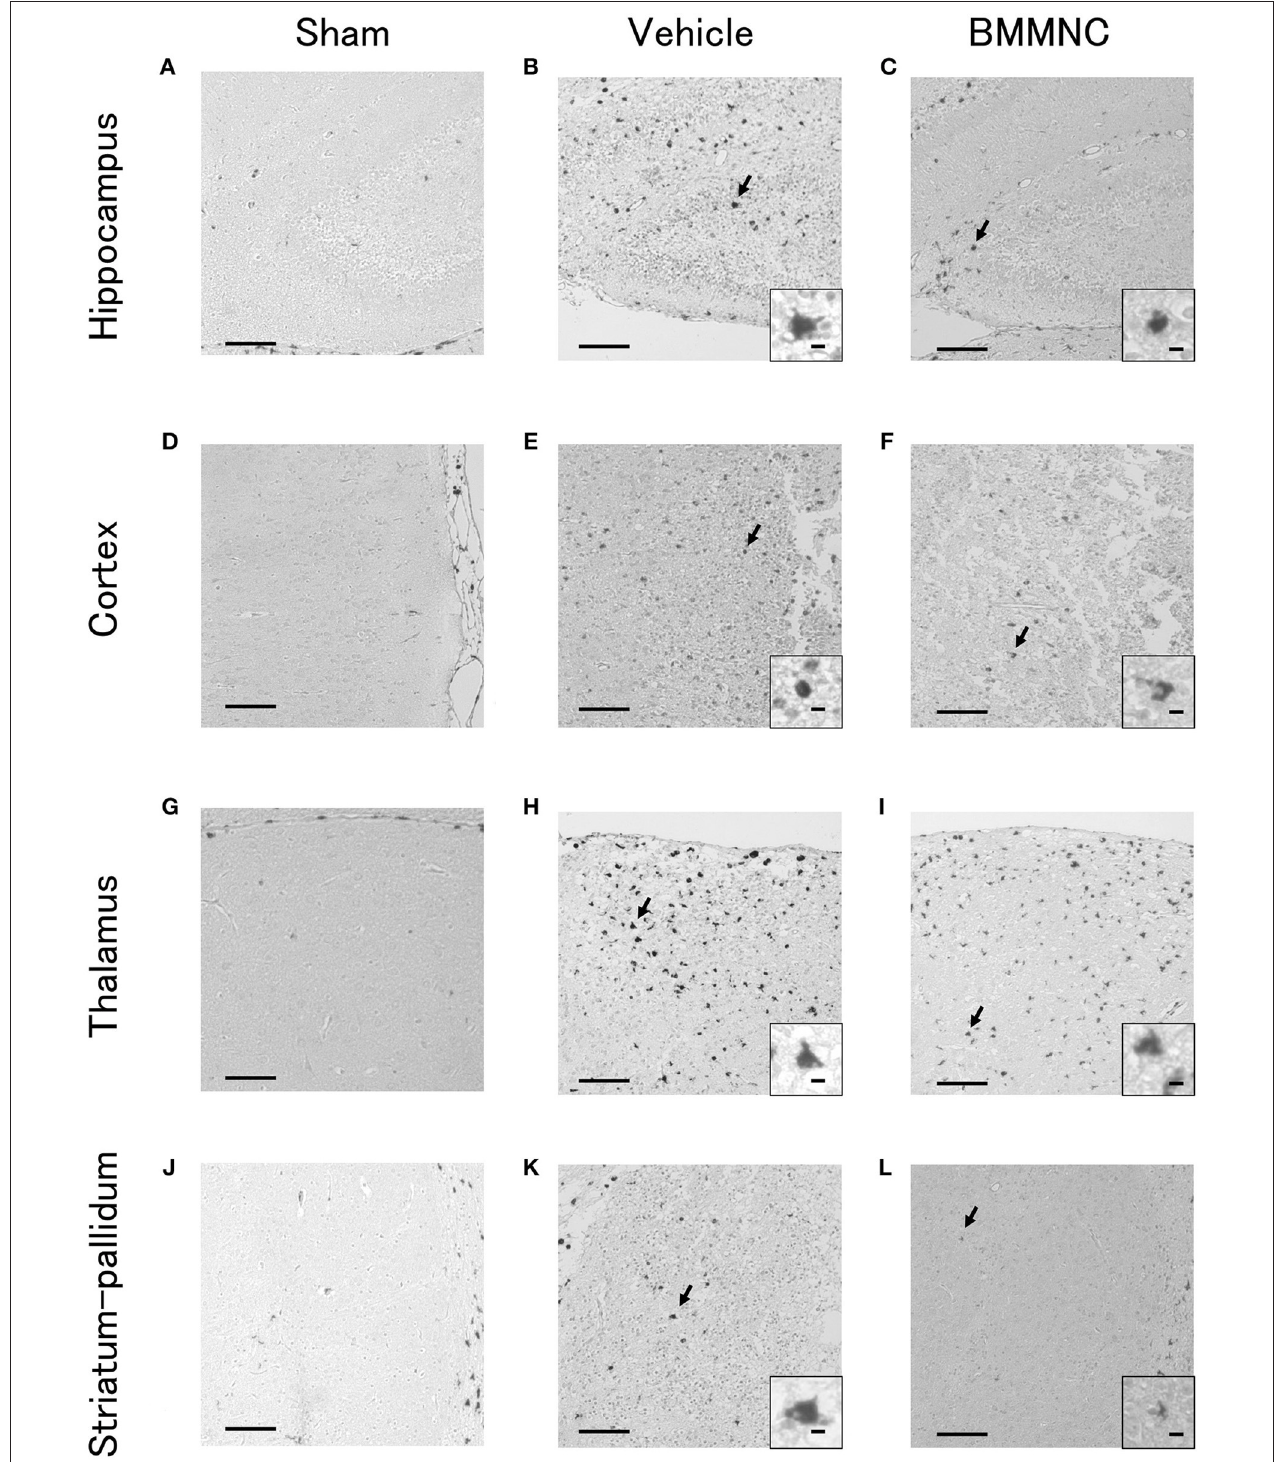
FIGURE 4 | Representative photomicrographs of ED1-positive cells in the hippocampus (A–C) , cortex (D–F) , thalamus (G–I) , and striatum-pallidum (J–L) 48h after HI. Bar = 100 µ m. Insets show higher magnification views ( × 400, bar = 5 µ m).